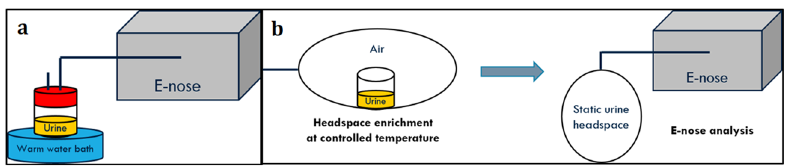
Figure 5. Sample preparation procedure: ( a ) dynamic urine headspace, ( b ) static urine headspace.